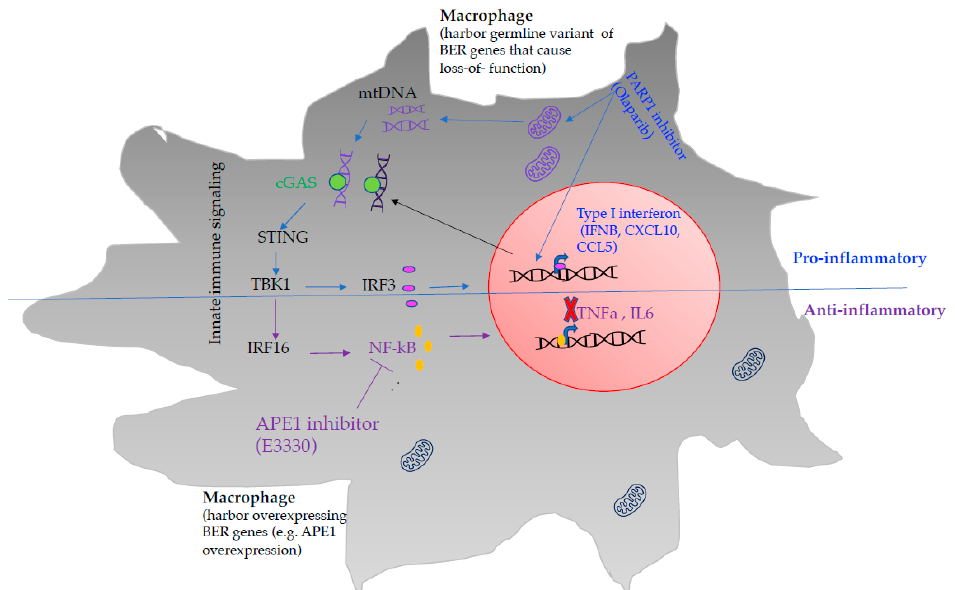
Figure 4. BER-based therapeutic intervention in immune cells (macrophage) modulates inflammatory signaling. Macrophages harbor pathogenic germline variant of BER genes treated with PARP1 inhibitor (Olaparib) will likely accumulate unrepaired products such as PARP1-DNA complex and generate cytosolic DNA to stimulate cGAS/STING pathways and enhance type interferon response (represent by blue color). In contrast, macrophages harbor overexpression of BER genes (e.g., APE1) targeted by APE1 inhibitor (E3330) suppresses NF-kB mediated inflammatory response (represented by purple color).